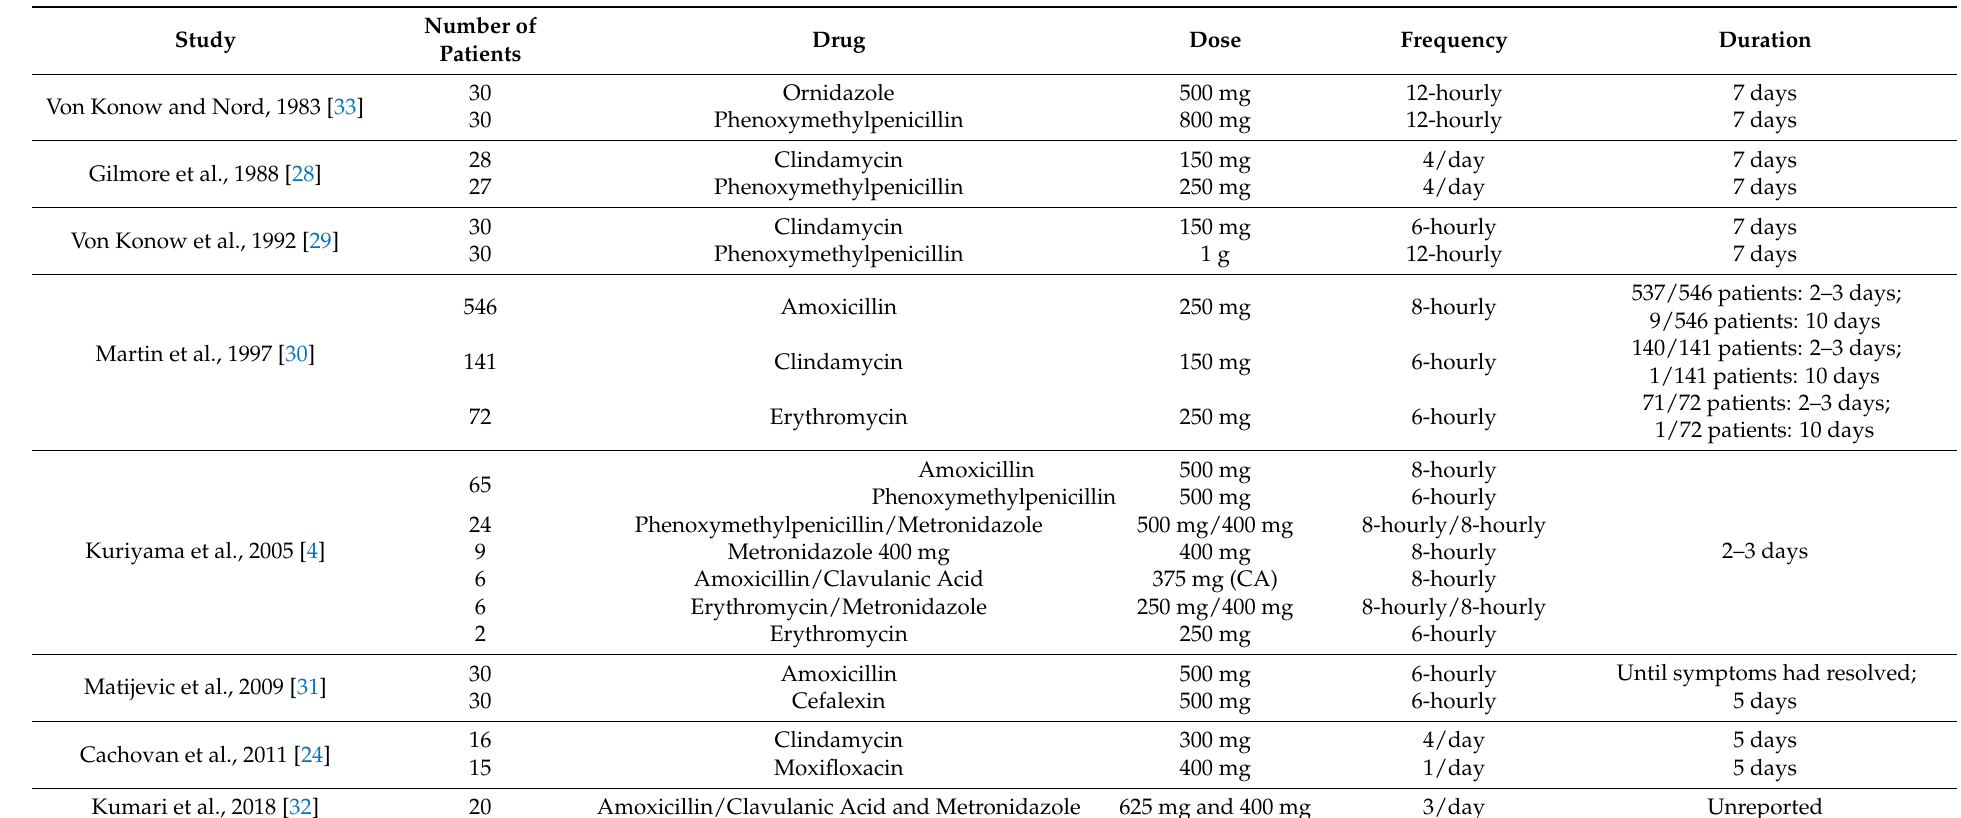
Table 2. Antibiotic